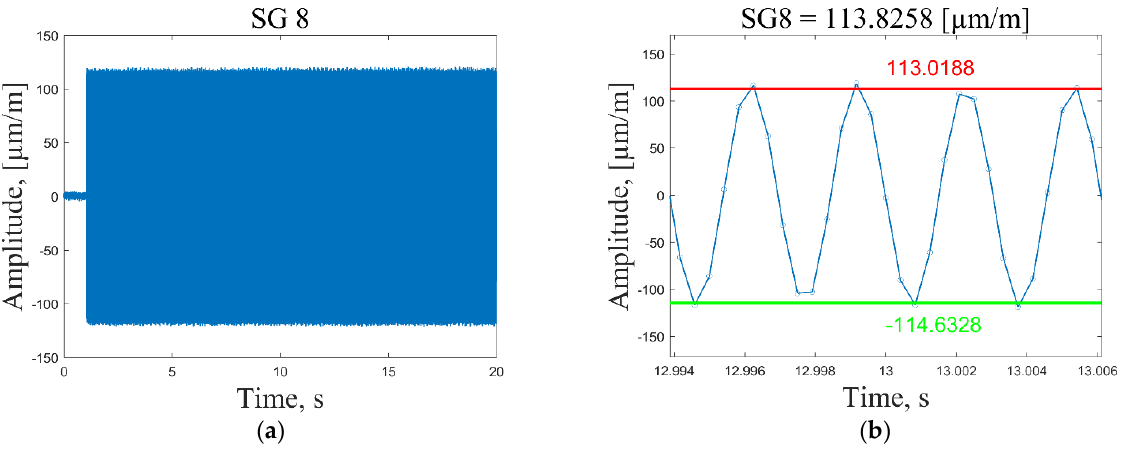
Figure 12. Recorded time series of strain response of the plate excited by a periodic sine wave signal corresponding to the first resonant frequency with a 1 V peak-to-peak vibration amplitude ( a ); calculated average peak-to-peak values for strain gauge 8 ( b ).